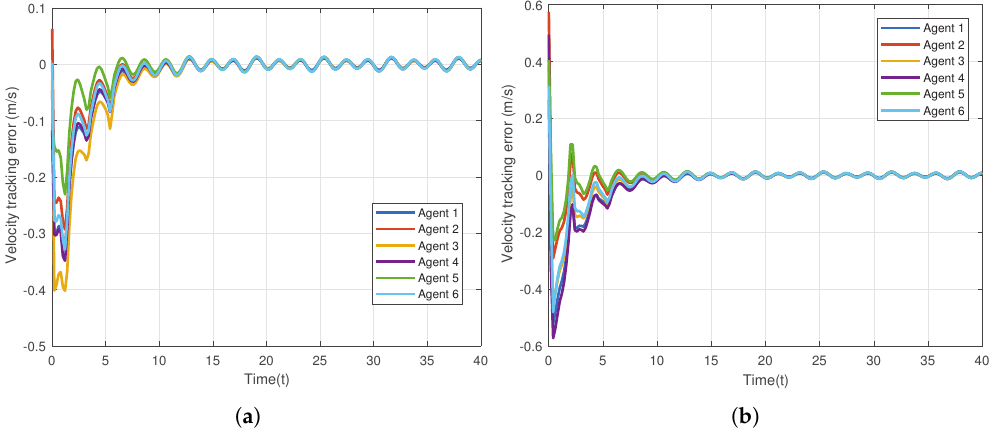
Figure 3. Tracking errors of velocities of 6 agents in the networked Euler-Lagrange system. ( a ) Tracking errors for X-axis; ( b ) Tracking errors for Y-axis.